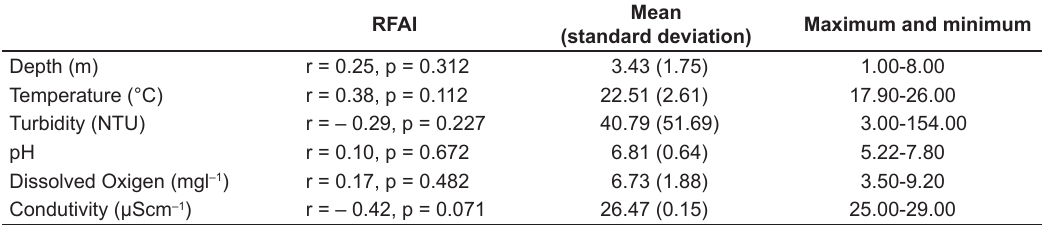
Table 4. Relationship among the RFAI and the environmental variables.